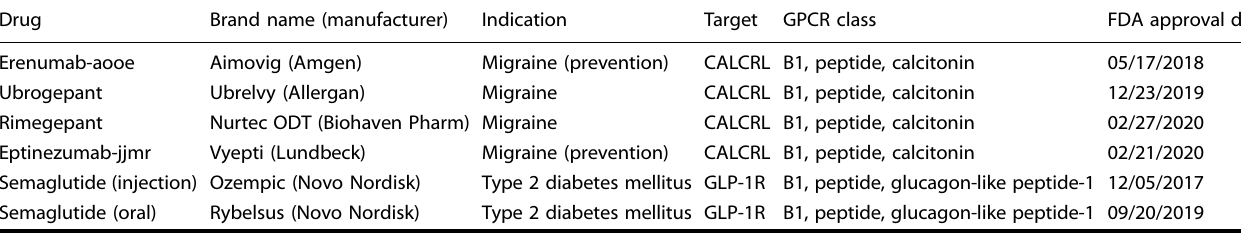
Table 2. Newly approved drugs targeting class B GPCRs in the past 3 years Drug Brand name (manufacturer)